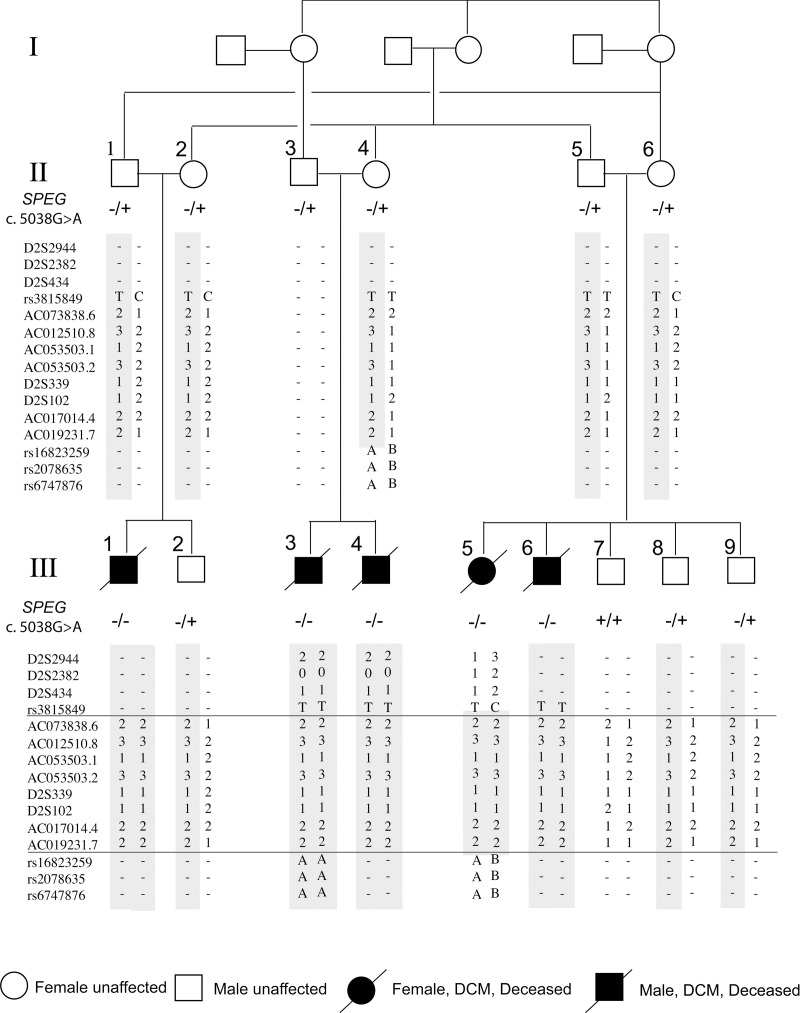
Haplotype analysis in the consanguineous family.The haplotype analysis based on microsatellite markers from 2q35-q36 revealed a founder haplotype (grey bar) for which the patients are homozygous. The horizontal lines mark the linkage border. All the family members whose haplotypes appear as open symbols underwent complete physical and cardiac evaluation and were found to be healthy. SPEG c. 5038G>A: -/- homozygous for the variation, -/+ heterozygous, +/+ reference allele.